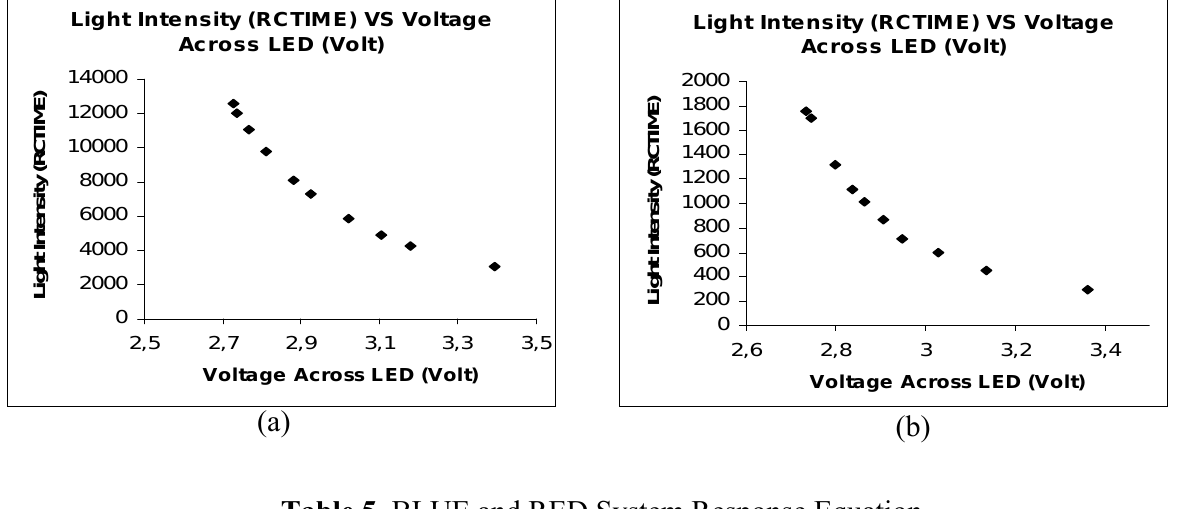
Figure 9. System Response Test for (a) BLUE System (b) RED System.